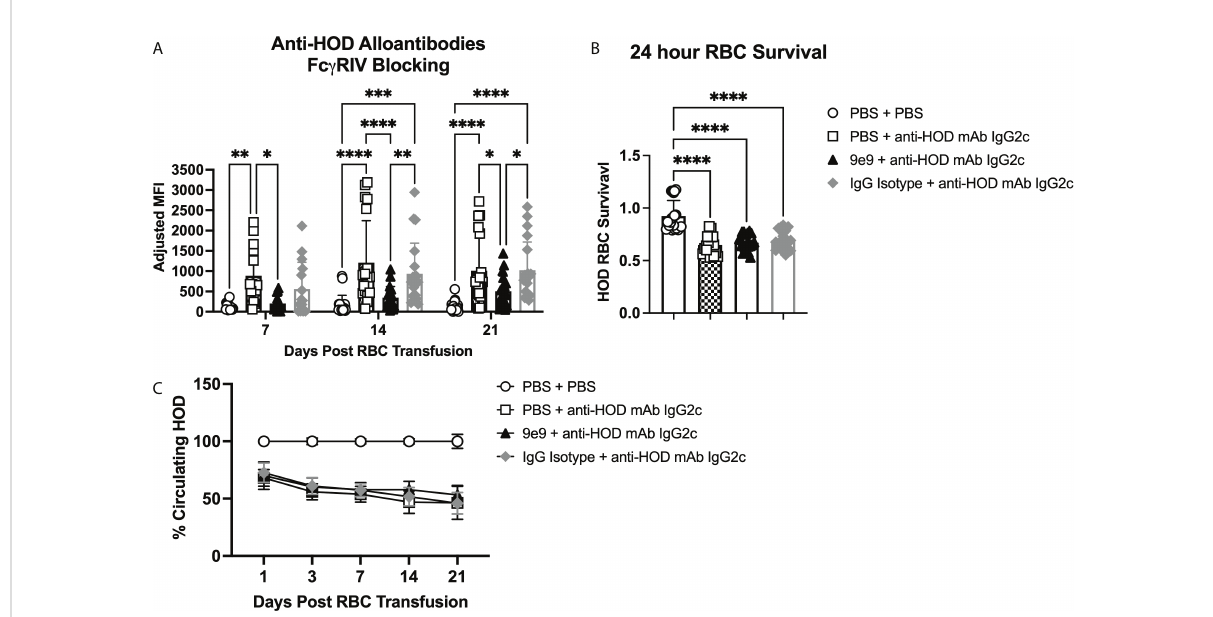
FIGURE 2 RBC alloantibody production requires Fc g RIV. B6 recipient mice were passively immunized with 1 m g of anti-HOD IgG2c followed by an RBC transfusion 2 hours later. Some animals received an infusion of 1 m g of 9e9, an anti-Fc g RIV blocking antibody, or IgG isotype control 30 minutes prior to passive immunization. Sera was collected weekly and (A) analyzed for anti-HOD alloantibodies by fl ow crossmatch. To assess RBC clearance, survival of HOD RBCs was determined at (B) 24 hours and (C) over a 3-week time course. Data shown are cumulative of 4 independent experiments with 4-5 mice per group. Statistical analysis was performed with a repeated measures 2-way ANOVA or a one-way ANOVA with Tukey ’ s multiple comparisons test, ****p<0.0001, ***p<0.001, **p<0.05, *p<0.05, comparisons without signi fi cance are not